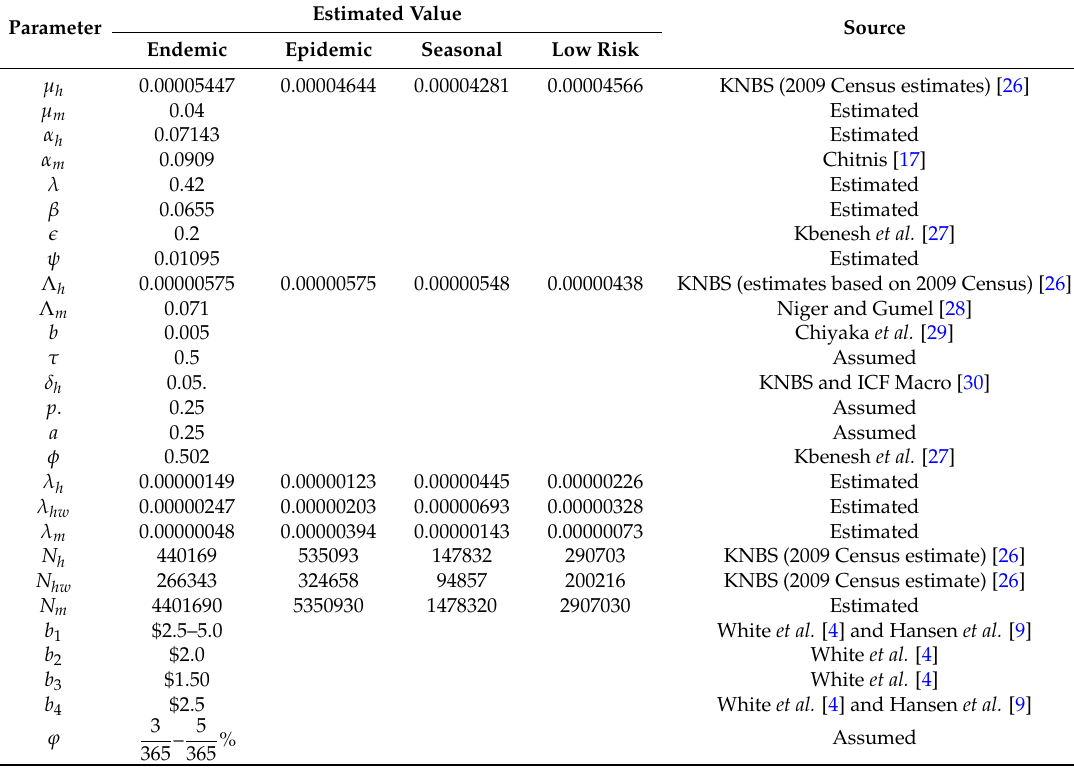
Table 5. Parameter